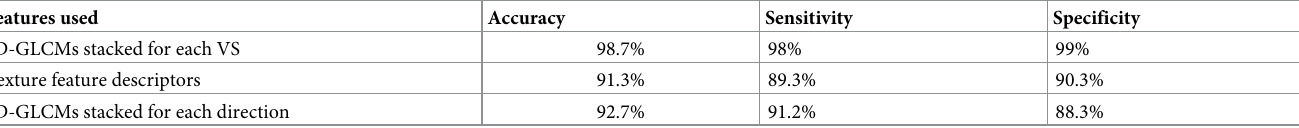
Table 7. Results of the ablation study for the type of features presented to the LSTM-based deep fusion model. Features